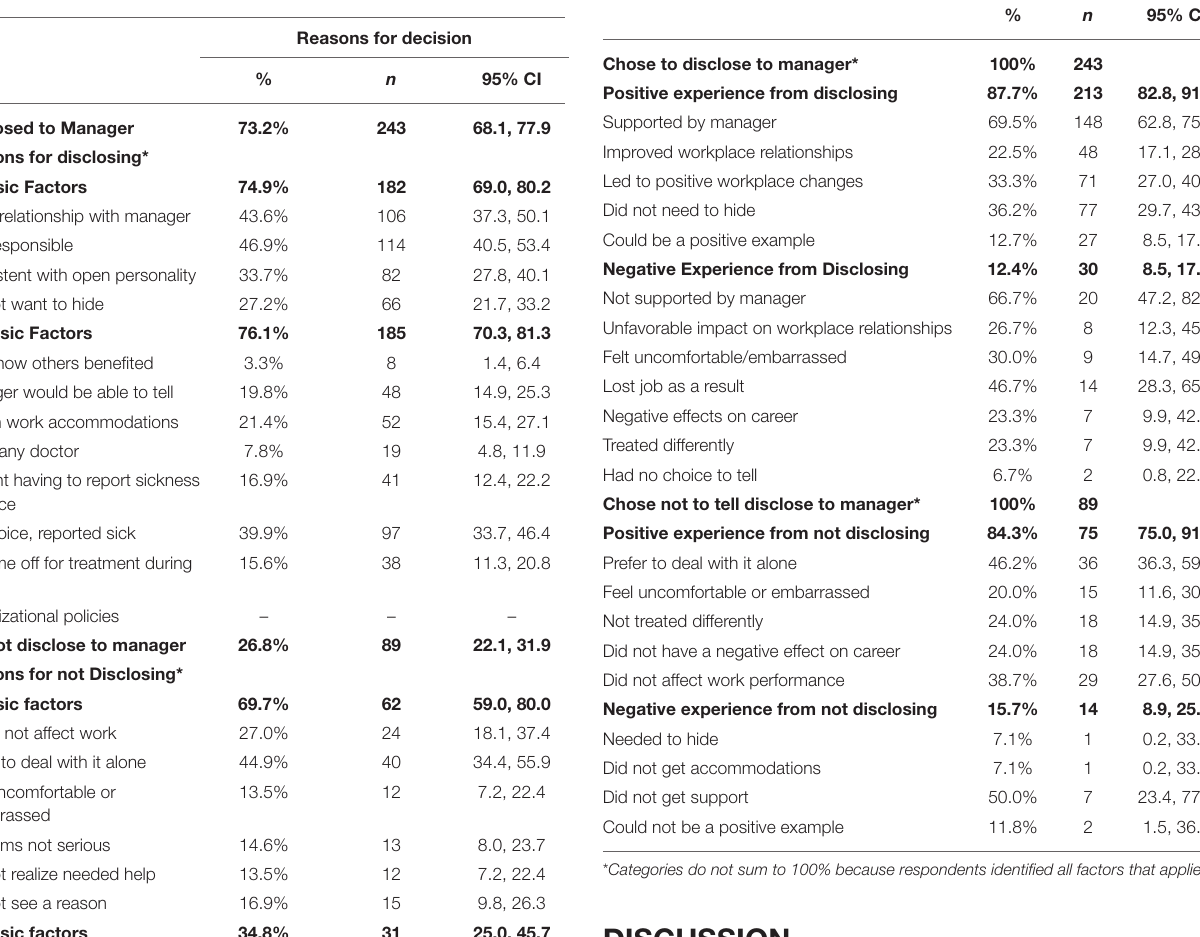
TABLE 3 | Disclosure decision